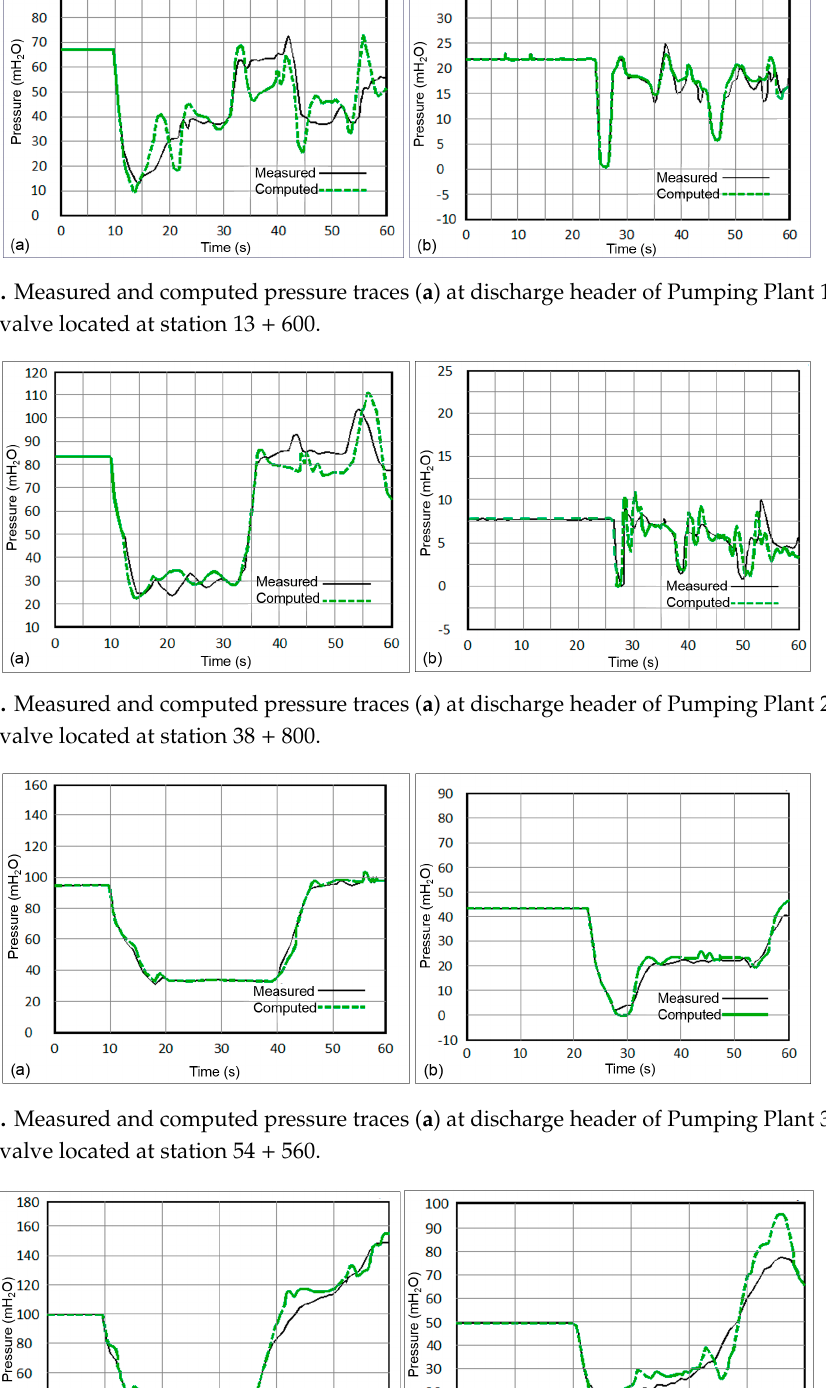
Figure 17. Measured and computed pressure traces ( a ) at discharge header of Pumping Plant 5 and ( b ) at the air valve located at station 84+447. 6. Conclusions This paper presents the solution in order to ensure that a pumping pipeline of large dimensions operates properly to avoid potential damage due to the occurrence of hydraulic transients. The original design of the aforementioned pipeline was not suitable because the devices for transient control were undersized and insufficient to suppress downsurge pressures when the simultaneous failure of the five pumps occurs at the five pumping stations caused by power cut, as a result of the moment of inertia of all the pumps being incorrectly considered during the design. Furthermore, the hydraulic transient analysis revealed that the sub-atmospheric pressures at the first, third and fifth pipeline segments may be reduced to the vapor pressure of the liquid, which could lead to water column separation. Hence, supplementary surge suppression devices were needed to prevent potential catastrophic damage to the pipeline. With the intention of effectively protecting the pumping pipeline, an exhaustive transient analysis was conducted for the design and testing of additional devices for transient control, considering the simultaneous power failure of all the pumps at the five pumping stations. The results